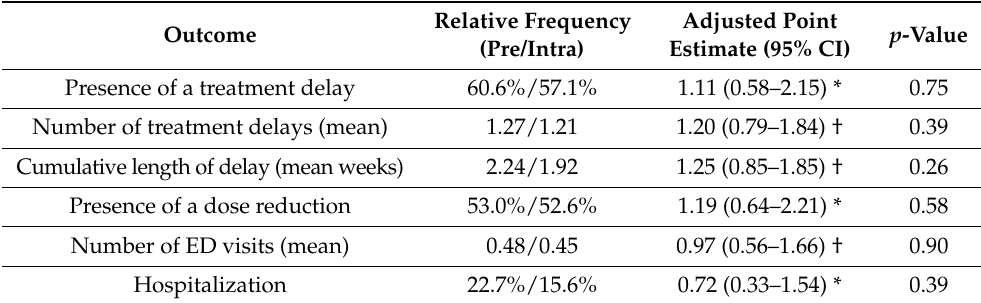
Point estimates were represented as odds ratios for binary outcomes (*) and rate ratios (†) for continuous data. (Abbreviations: ED, emergency department; CI, confidence interval; pre, pre-pandemic period; intra, intra-pandemic period).